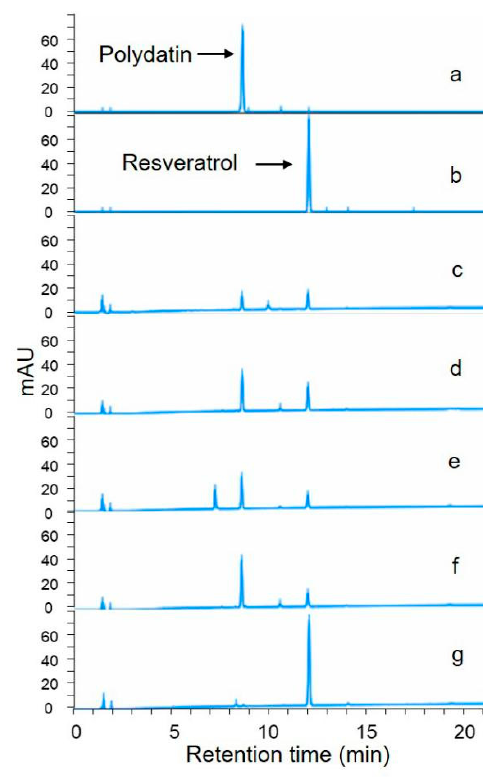
Figure 1. Representative high-performance liquid chromatography (HPLC) chromatogram of biotransformation activity screening of positive strains. ( a ): polydatin standard; ( b ): resveratrol standard; ( c ): Z1; ( d ): Z3; ( e ): Z4; ( f ): Z5; ( g ): X1. Table 2. Biotransformation rate from polydatin to resveratrol of positive endophytes. No. Biotransformation Rate (%)